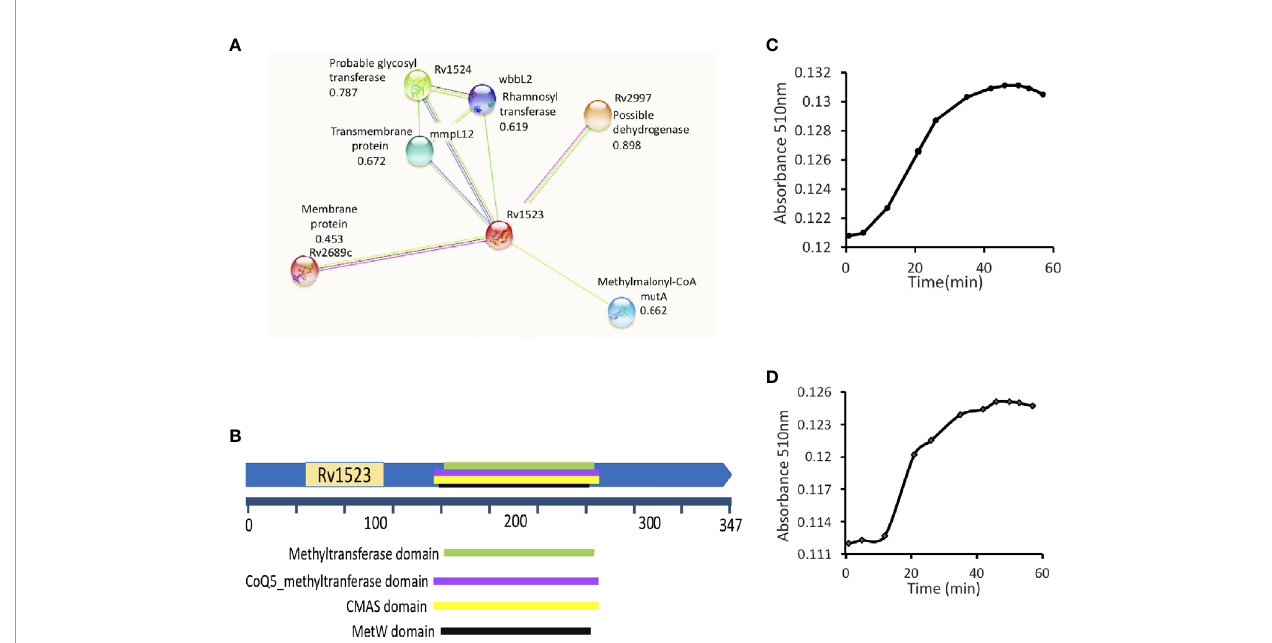
FIGURE 1 | Rv1523 is a fatty acid MTase. (A) STRING analysis reveals the top 10 interaction partners, both known and putative of M. tuberculosis H 37 Rv Rv1523 protein. The score for each interaction partner is assigned and given. The score for Rv1523 association was found to be 0.672 for mmpL12, a transmembrane protein, 0.787 for a probable glycosyltransferase and 0.898 for dehydrogenase enzyme. (B) Functional domain analysis of M. tuberculosis Rv1523 protein. The InterProScan analysis result shows the presence of Mycolic acid cyclopropane synthetase domain (CMAS) other than MTases domain, SAM-binding domain, MetW domain, CoQ5_methyltranferase domain. (C) The Adenosylhomocysteine methyltransferase enzyme (provided with the kit) was used as a positive control. Methyltransferase enzymatic activity analysis of Rv1523 was analyzed along with positive control, as a function of time, in a colorimetric based assay. (D)